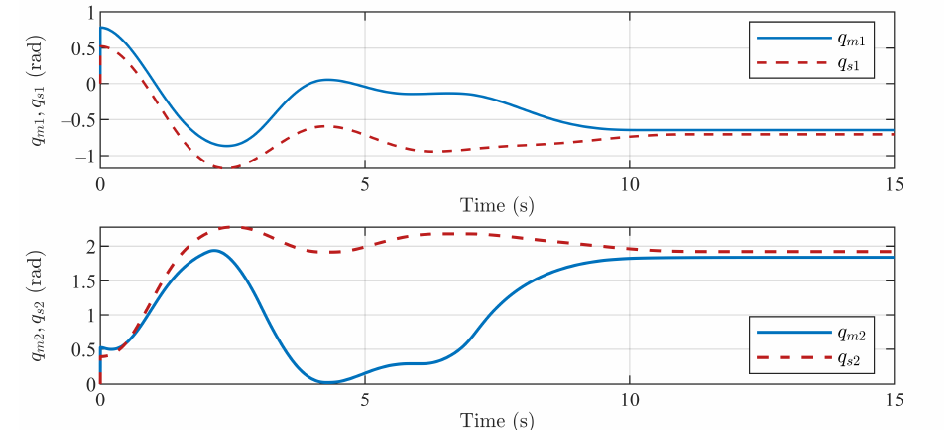
Figure 12. Joint positions with the method in Case 1.